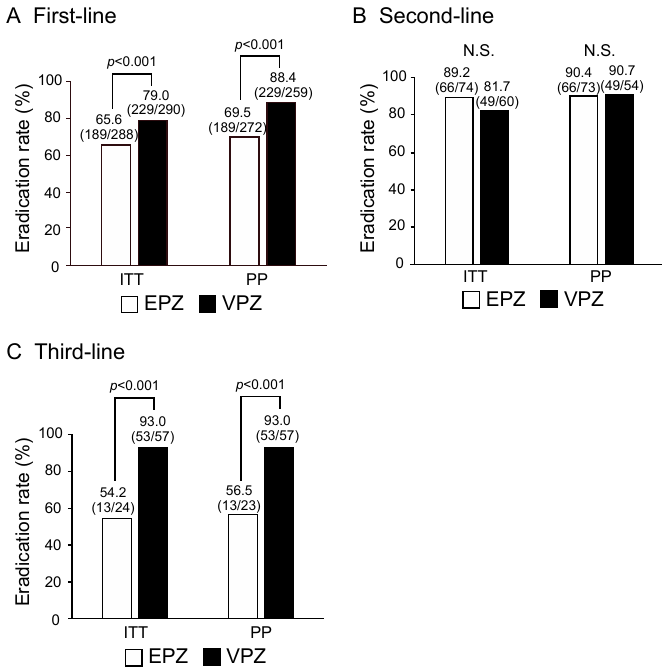
Figure 1. The overall success rates for first-, second-, and third-line H. pylori eradication between VPZ-based triple therapy and EPZ-based triple therapy. ( A ) The first-line eradication rates for VPZ-based triple therapy evaluated by intention-to-treat (ITT) and per protocol (PP) (79.0% and